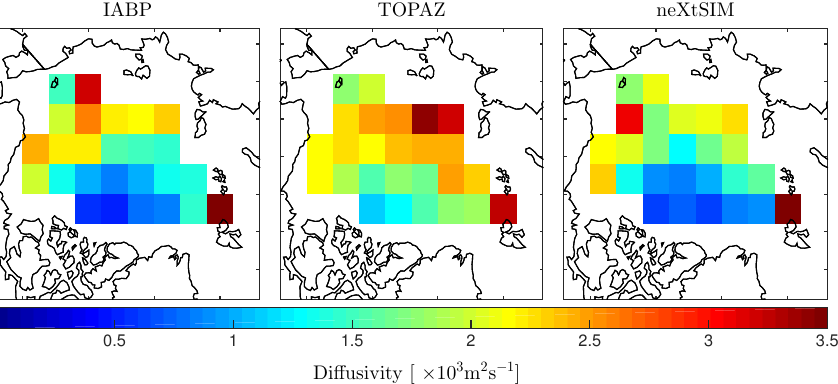
Figure 11. Diffusivity fields obtained from the analysis of the IABP buoys trajectories (left), TOPAZ float trajectories (middle) and neXtSIM float trajectories (right) for the winters 2007–2010. The diffusivity is averaged over boxes of 400 by 400km.